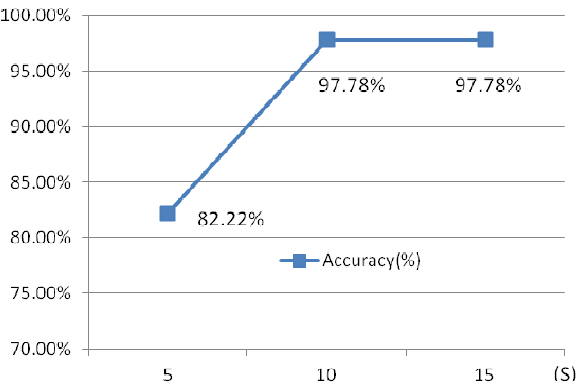
Figure 29. Comparison of different time intervals of ECG.